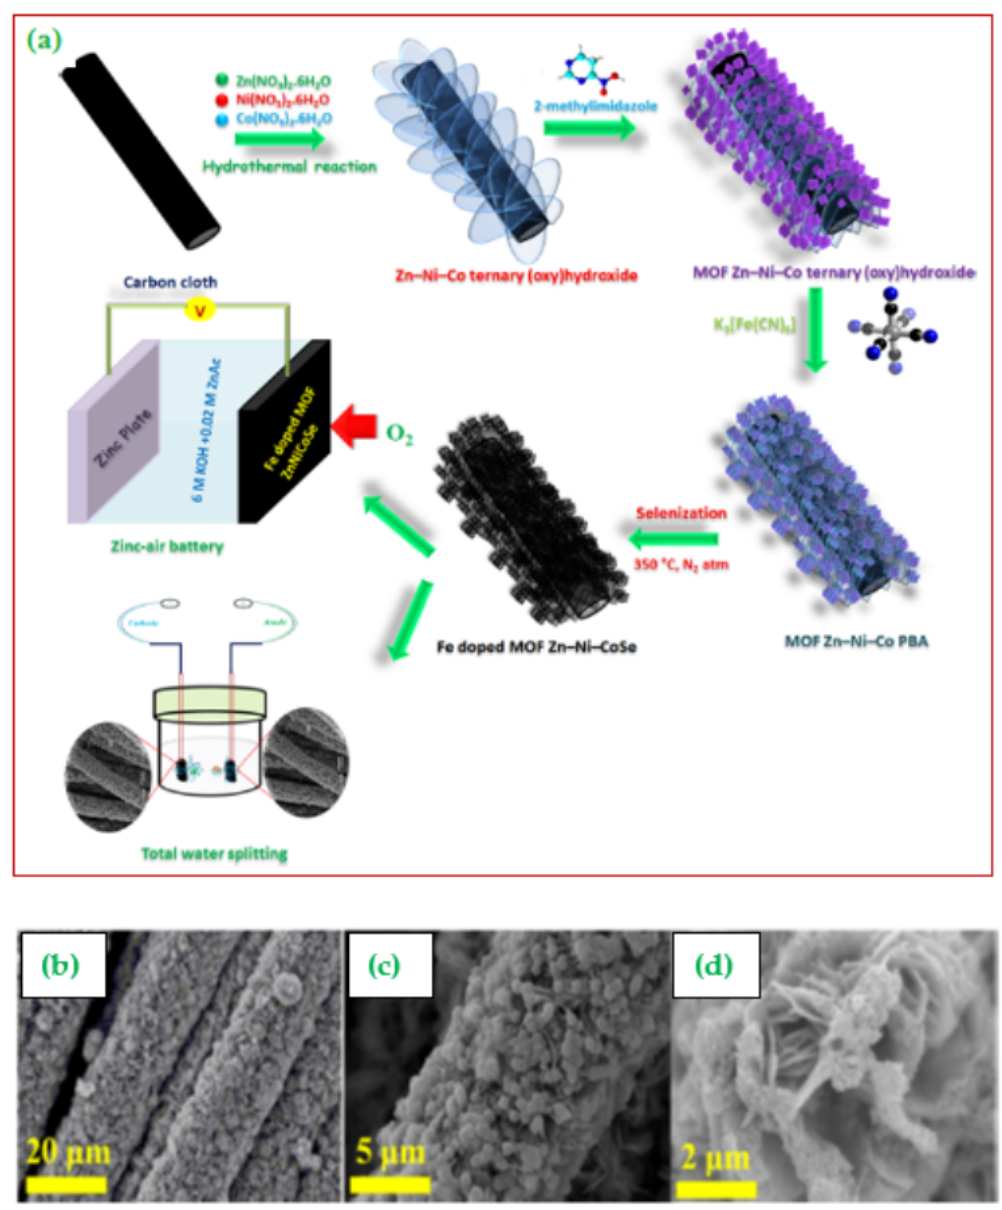
Figure 13. ( a ) Schematic representation of the synthetic strategy and electrochemical applications of Fe–doped MOF ZnNiCoSe@CC, and ( b – d ) low- and high-magnification FE–SEM images of